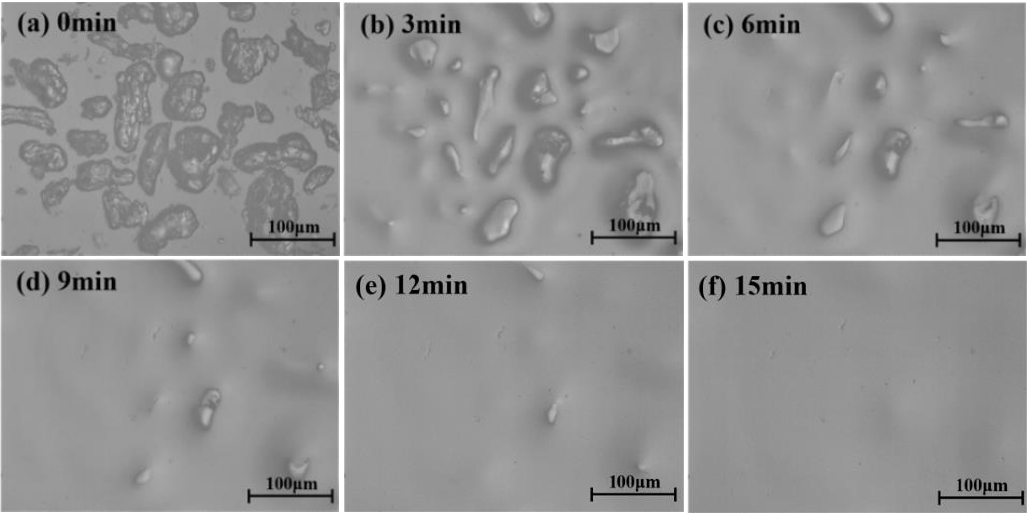
Figure 1. The dissolution process of polysulfone (PSF) powder in epoxy resin at 120 °C, followed by optical microscopy ( a ) 0 min, ( b ) 3 min, ( c ) 6 min, ( d ) 9 min, ( e ) 12 min, ( f ) 15 min.